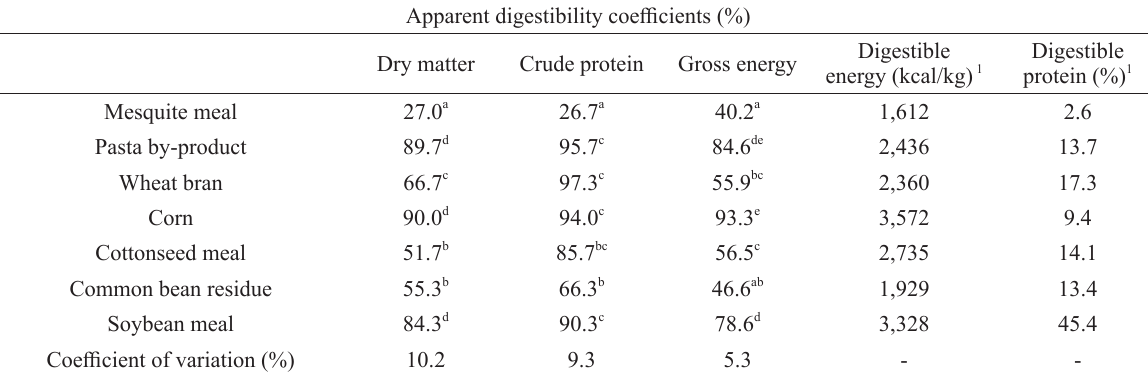
Apparent nutrients and energy digestibility coefficients (%) of different feed ingredients for tambacu juveniles.